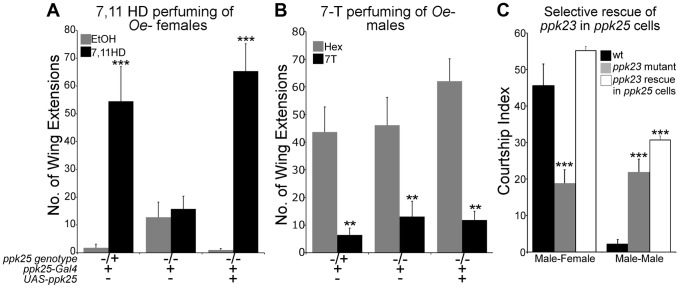

ppk25 is required for courtship stimulation by 7,11HD but not for inhibition of courtship by 7-T.A. The number of wing extensions performed by males with normal or mutant copies of ppk25, or by ppk25 mutant males in which ppk25 function is restored specifically in ppk25 cells, was measured in the presence of oe- females painted either with solvent alone or with a single female pheromone, 7,11HD. oe- females were pierced through the head with forceps, contributing to the low courtship background. These and all following assays involving perfumed oe- targets were conducted under normal laboratory lights [13]. n = 19–24; Mean ± SEM; ***p<0.001 (perfumed relative to solvent control). Error bars indicate the SEM for number of wing extensions and statistical significance was determined using the Kruskal-Wallis test followed by Dunn's post hoc test. B. The number of wing extensions displayed by males with normal or mutant ppk25 was measured in the presence of oe- males painted either with solvent alone or with a single male pheromone, 7T. In this experiment, males were raised in groups as this resulted in higher baseline courtship toward oe- targets, thereby allowing inhibition to be measured. n = 24–28; Mean ± SEM; **p<0.01; (Kruskal-Wallis test followed by Dunn's post hoc test to solvent control). C. The Courtship Index (CI, percentage of a ten minute observation time during which the male is courting [16]) was measured for control w1118 males, males mutant for ppk23, and ppk23 mutant males in which expression of ppk23 is targeted to F cells using the ppk25-Gal4 driver. Male-female courtship was measured in the presence of decapitated w1118 females to reduce behavioral feedback. Male-male courtship was performed with intact male targets in the light since ppk23 mutants display robust male-male courtship under these conditions [13], [14]. n = 30–40; Mean ±SEM; ***p<0.001 to wt. Error bars indicate the SEM for CI and statistical significance was determined using the Kruskal-Wallis test followed by Dunn's post hoc test.